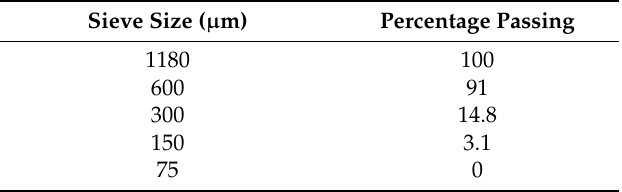
Table 3. Natural fine sand aggregate